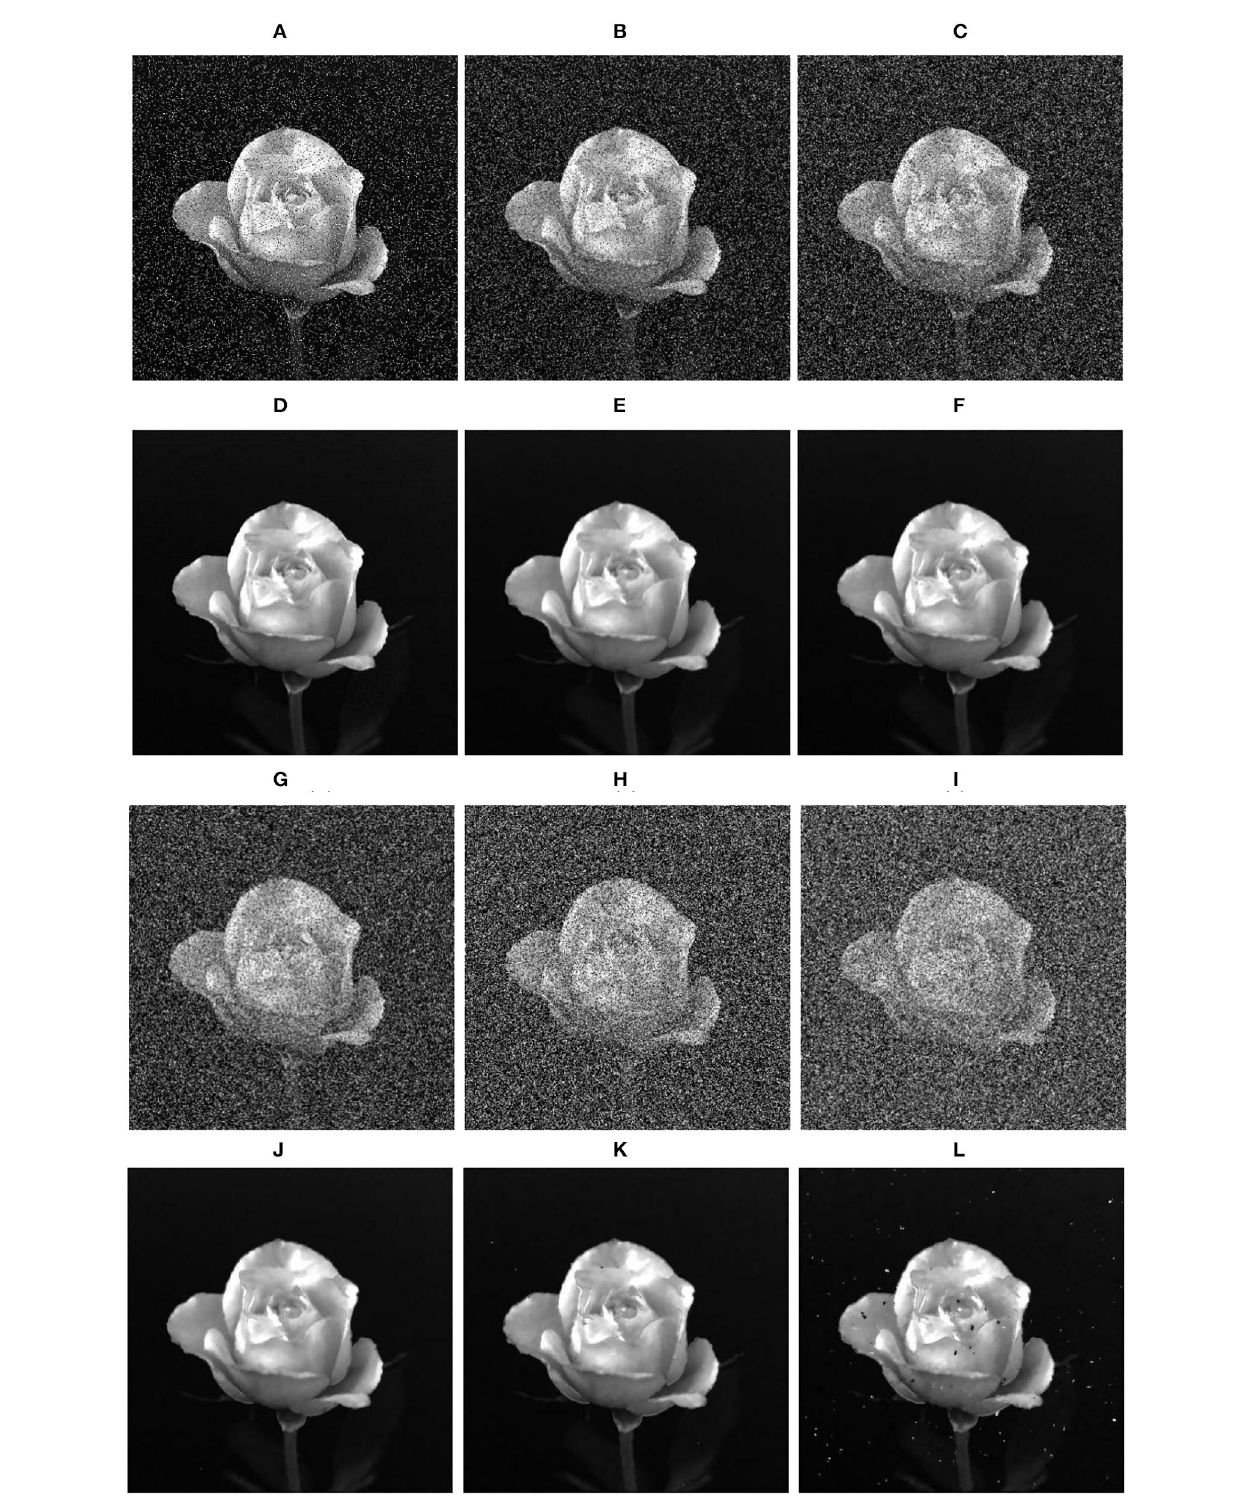
FIGURE 4 | The result of the edge-adaptive total variation for different intensities of salt and pepper noise (A) 10% salt and pepper noise map; (B) 20% salt and pepper noise map; (C) 30% salt and pepper noise map; (D) 10% salt and pepper noise map noise result graph; (E) 20% salt and pepper noise result graph; (F) 30% salt and pepper noise result graph; (G) 40% salt and pepper noise graph; (H) 50% salt and pepper noise graph; (I) 60% salt and pepper noise graph; (J) 40% salt and pepper noise result graph; (K) 50% salt and pepper noise result graph; and (L) 60% salt and pepper noise result graph.